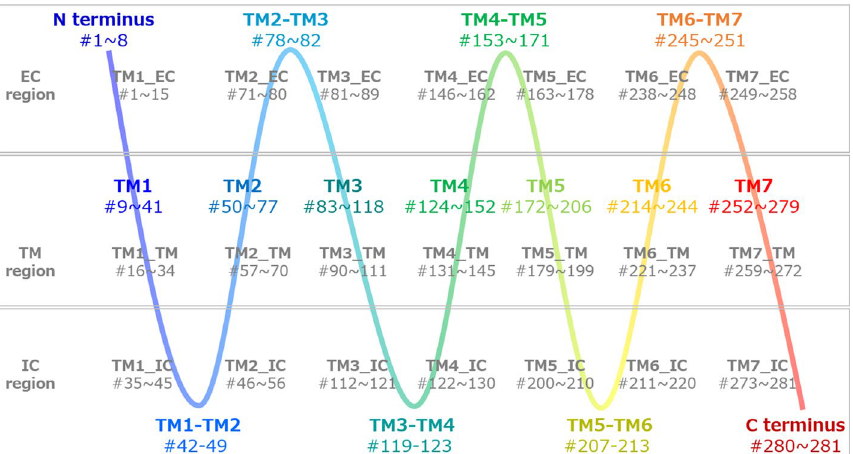
Figure 2. Definition of EC, IC, and TM regions. Based on the crystal structures of CXCR4 (PDB ID: 4rws) 18 and the snapshots of the MD simulations, we defined the structural regions of the TM helices as residue numbers from 9 to 41 (TM1), from 50 to 77 (TM2), from 83 to 118 (TM3), from 124 to 152 (TM4), from 172 to 206 (TM5), from 214 to 244 (TM6), and from 252 to 279 (TM7 helix regions). The other residues are located in the N-terminus (from 1 to 8), C-terminus regions (from 280 to 281), or turn regions (e.g., the turn between TM1 and TM2 helices [TM1–TM2]). This definition is gradually represented from blue to red. To examine which function (and region), i.e., the signaling from the ligand (EC region), the signaling to the G protein (IC region), or the transmission of the signal from EC to IC regions (TM region), the important residues were involved in, we segmented 1 helix (e.g., TM1, the residue numbers from 9 to 41) into 3 regions, EC, IC, and TM. First, we defined the TM region, which consisted of residues located from the 8th residue from the N-terminus to the 8th residue before the C-terminus of TM1 (TM1_TM, the residue numbers from 16 to 34). The EC region consisted of residues located before the 8th residue from the N-terminus of TM1 (the residue numbers from 9 to 15) and N-terminus (from 1 to 8). The IC region consisted of the residues located after the 8th residue from